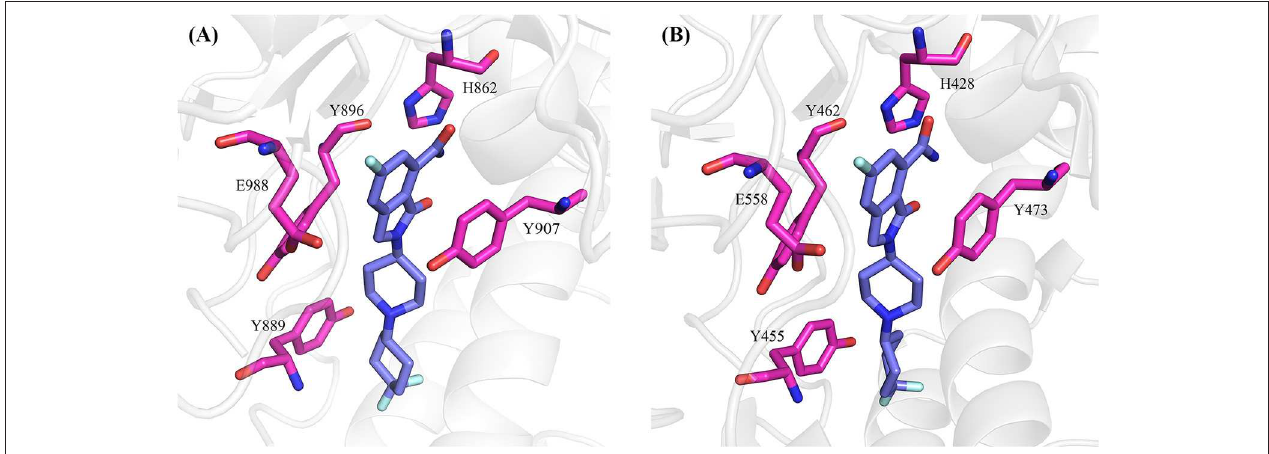
FIGURE 6 | The hot-spot residues in PARP-1 ( A , PDB ID: 5A00) and PARP-2 ( B , PDB ID:4ZZY). The proteins are shown in cartoon, and the hot-spot residues and ligand are shown in sticks.